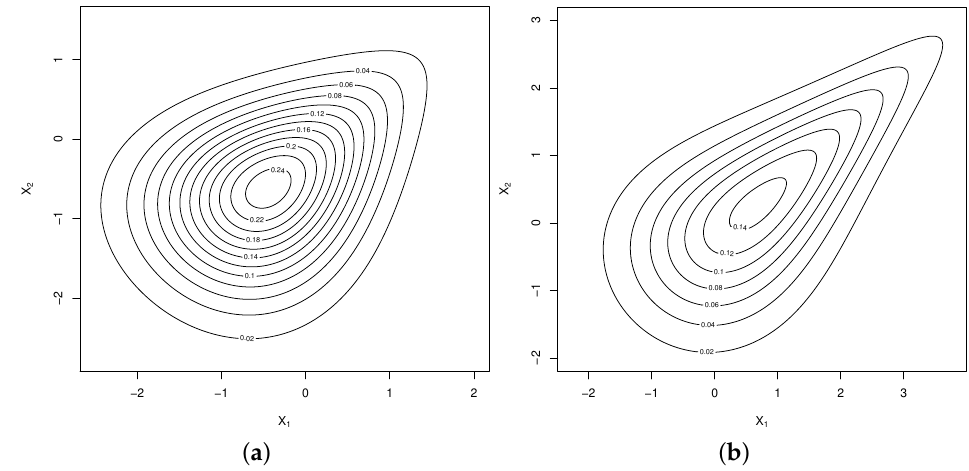
Figure 1. Contour plots: ( a ) BPHN(0,1,1.75,0,1,2.25,2), and ( b ) BPHN(0,1,0.5,0,1,0.75,0.75).